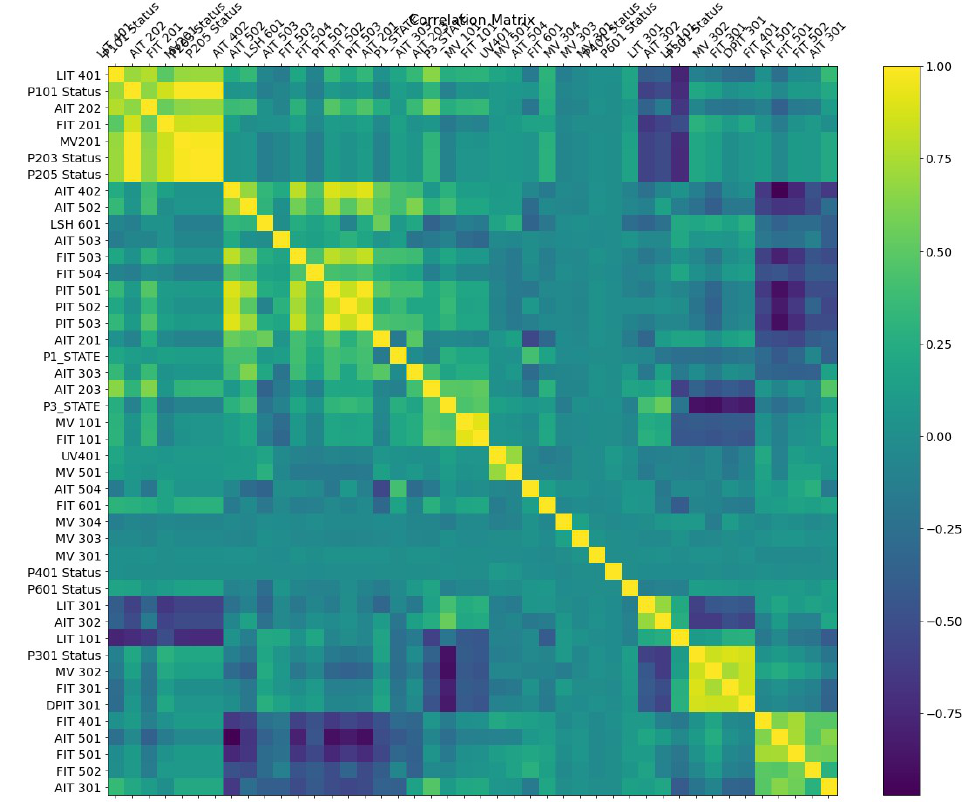
Figure 10. SWaT correlation